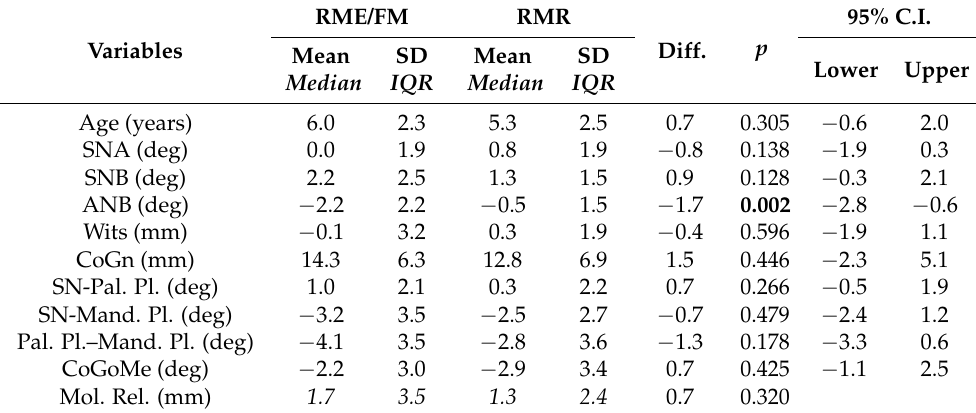
Table 4. Descriptive statistics and statistical comparisons (independent sample t test) for the T2– T3